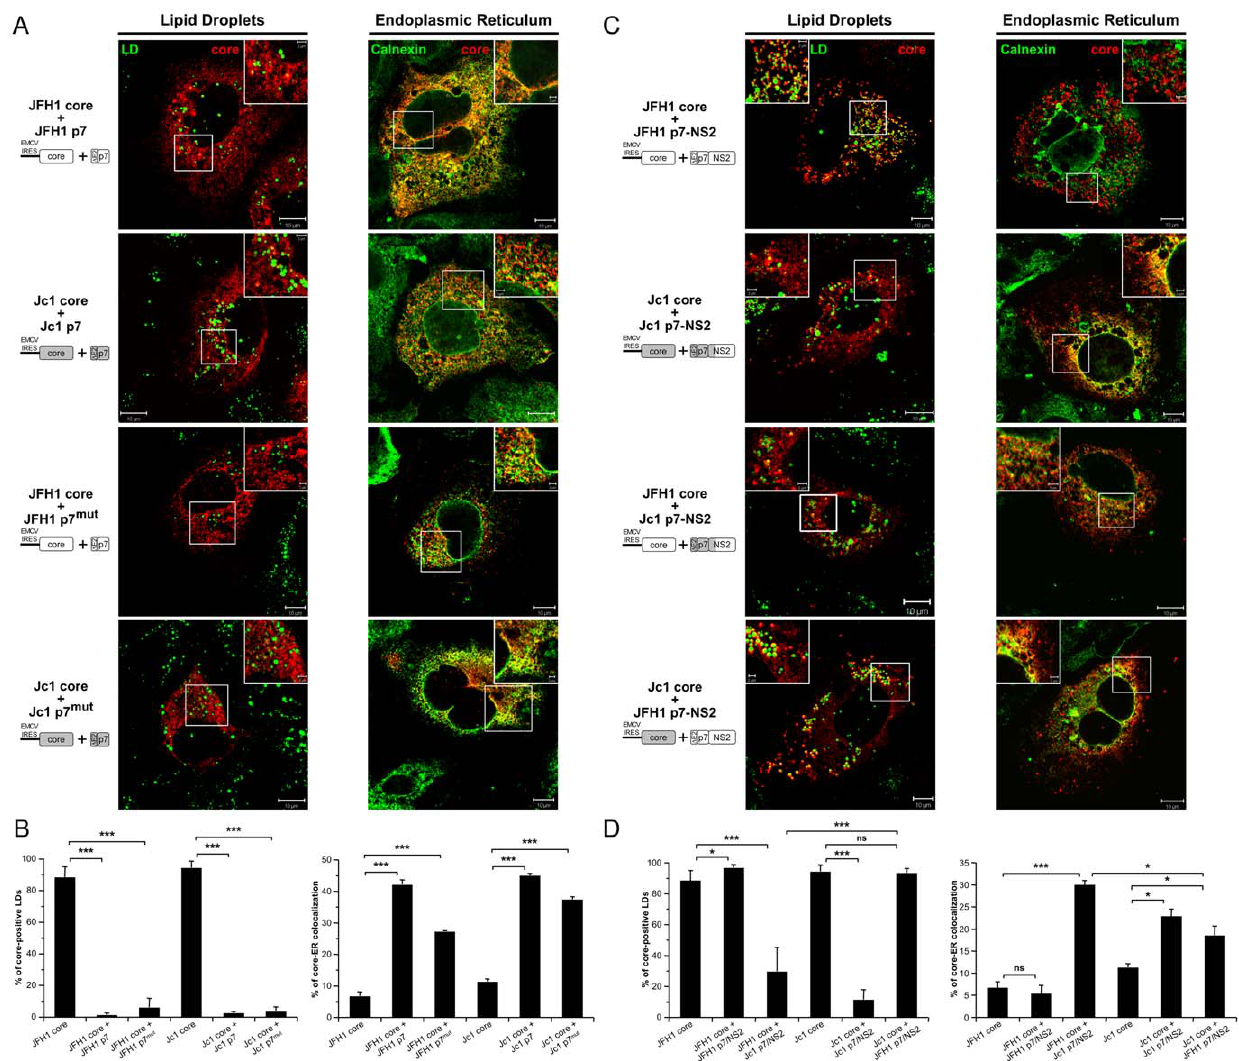
Figure 6. Strain-specific influence of p7 and NS2 on the intracellular localization of core. Huh7.5 cells stably expressing p7 or mutated p7, JFH1-p7 mut and Jc1-p7 mut (RR33/35AA JFH1-p7 or KR33/35AA Jc1-p7 respectively) proteins ( A , B ) and p7-NS2 ( C , D ) from JFH1 and J6-CF (Jc1) isolates were transfected with plasmids expressing core from the same HCV strain or from the other isolate. 72 h post-transfection, cells were stained for LDs, Calnexin, and HCV core proteins. Intracellular localization of core proteins (red channel) in LD or ER (green channels) was analyzed by confocal microscopy. Typical patterns of intracellular localization of either protein are shown. The scale bars are provided in each panel as well as in zooms from squared areas. The constructs expressed in transfected cells are depicted above each panel ( A , C ). The frequency of core-positive LDs (mean % 6 SD) was determined in HCVcc-containing cells stained for core and LDs (left panel). The percentages of core-ER colocalization (mean % 6 SD) were determined by expressing the coefficients of determination based on Pearson’s correlation coefficients of colocalization of core and Calnexin (right panel). For each condition, 30–50 cells were quantified. (*), P , 0.05; (**), P , 0.01; (***), P , 0.001; (ns), no significant difference ( B , D ).